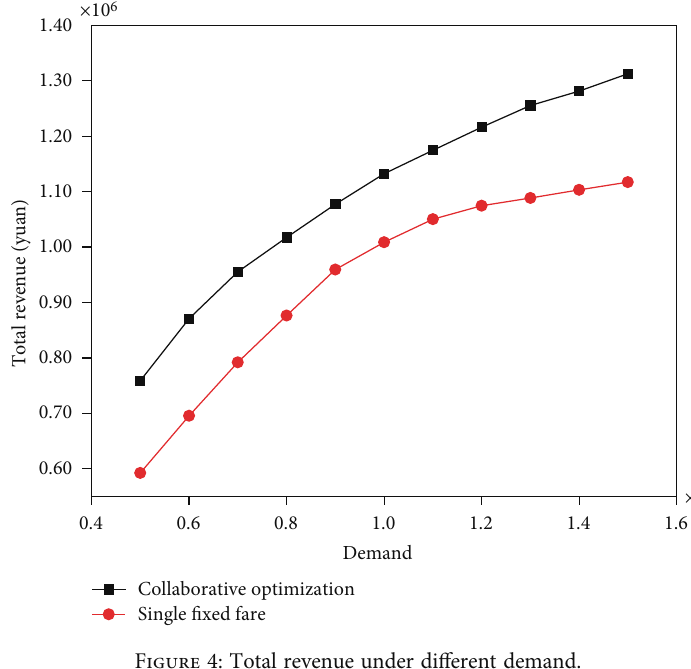
Figure 4: Total revenue under di ff erent demand.